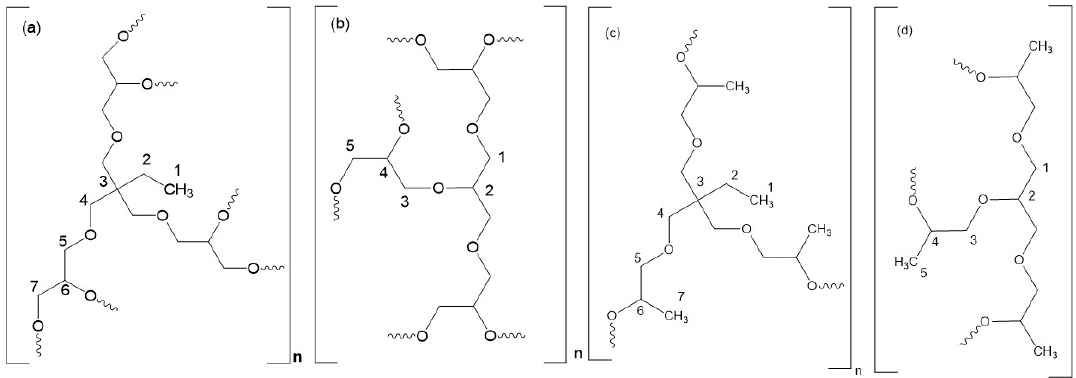
Figure 5. Proposed structures for (a) PTMPGC, (b) PGLYGC, (c) PTMPPC and (d) PGLYPC